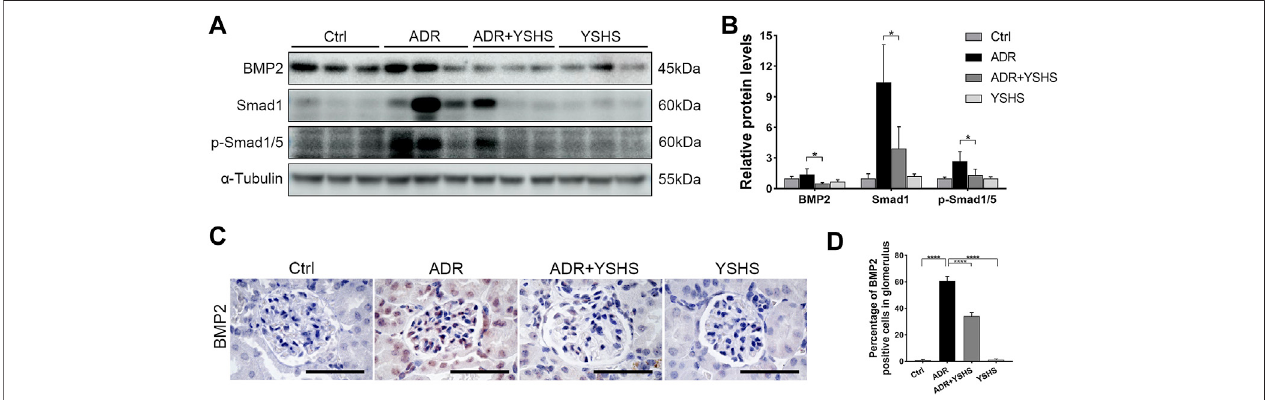
FIGURE6| YSHSgranuleinhibitstheBMP2/Smadsignalingpathway. (A) TheexpressionofBMP2,Smad1,andp-Smad1/5weredeterminedbyWesternblot. α - Tubulin was used as a loading control. (B) The quanti fi cation of the relative intensities of blots showed that the YSHS granule reduced the protein expression of BMP2, Smad1,andp-Smad1/5intheADR-induced FSGSmodel. (C) Representative IHCstainingofBMP2intheindicatedgroups. (D) Thequanti fi cationoftheBMP2positive cells in glomerulus revealed thatthe YSHS granule obviously decreasedthe expression ofBMP2 inADR-induced FSGS model. N = 6in each group, the data were shown asmean ±SD, one-way ANOVA analysisfollowed byTukey post-hoc tests asappropriate for multiple comparisons, * p < 0.05, **** p < 0.0001. scale bar: 50 µm.